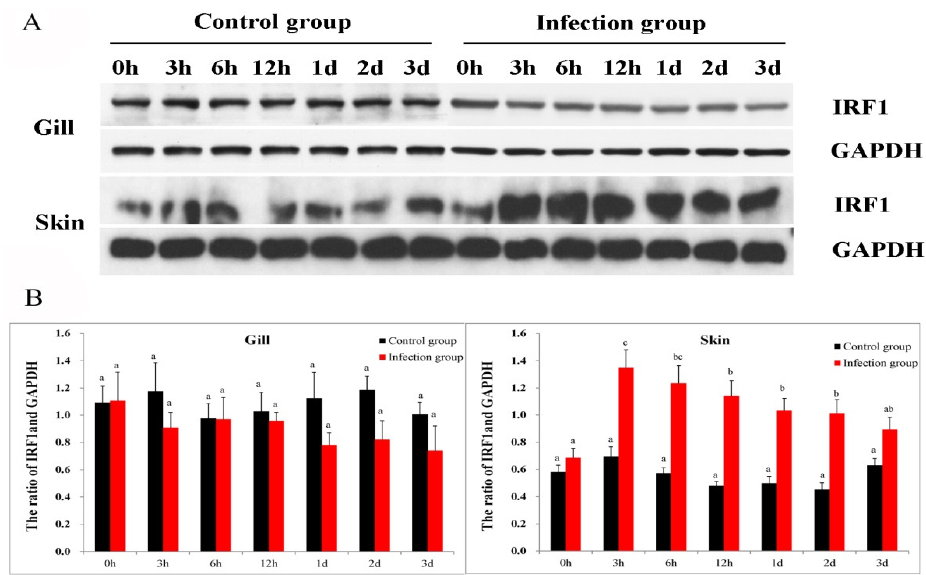
Figure 3. Western blot analysis of ToIRF1 proteins in gill and skin after infection with Cryptocaryon irritans (0, 3, 6, 12 hpi, 1 d, 2 d, and 3 d) in Trachinotus ovatus . ( A ) Western blot analysis was used to detect ToIRF1 expression. The experiment was divided into two groups, the control and infection groups. Lines 1 and 3 indicate the protein levels of ToIRF1 in gill and skin, respectively. Lines 2 and 4 indicate the levels of reference protein. ( B ) The corresponding ratio of gray values of ToIRF1 and GAPDH proteins; bars on the same group with different letters are significantly different from one another ( p < 0.05).